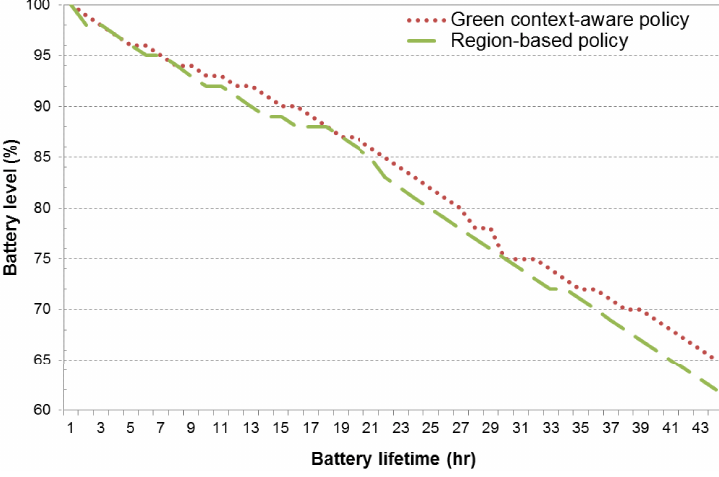
Figure 6. Battery lifetime of green context-aware sensing policy with a batch size of eight samples and variable reading